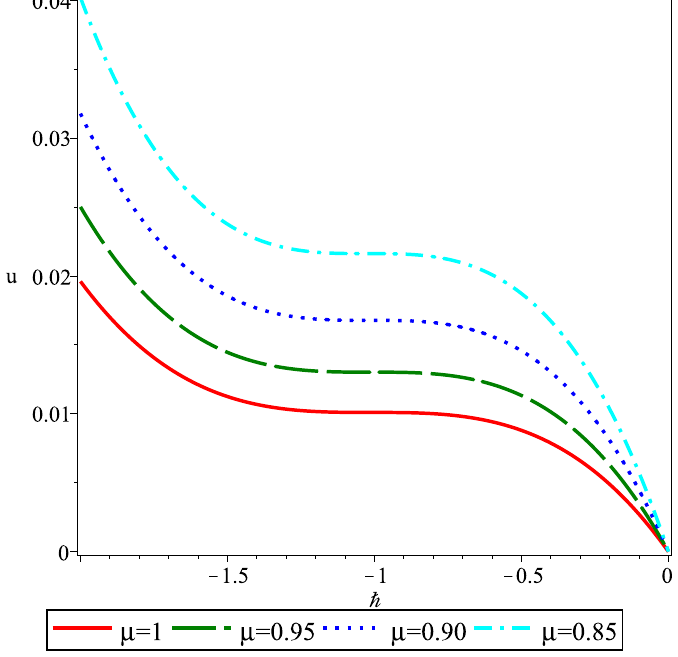
Figure 3. (cid:125)(cid:125)(cid:125) -curve of u ( t ) at t = 0.01 for various values of µ